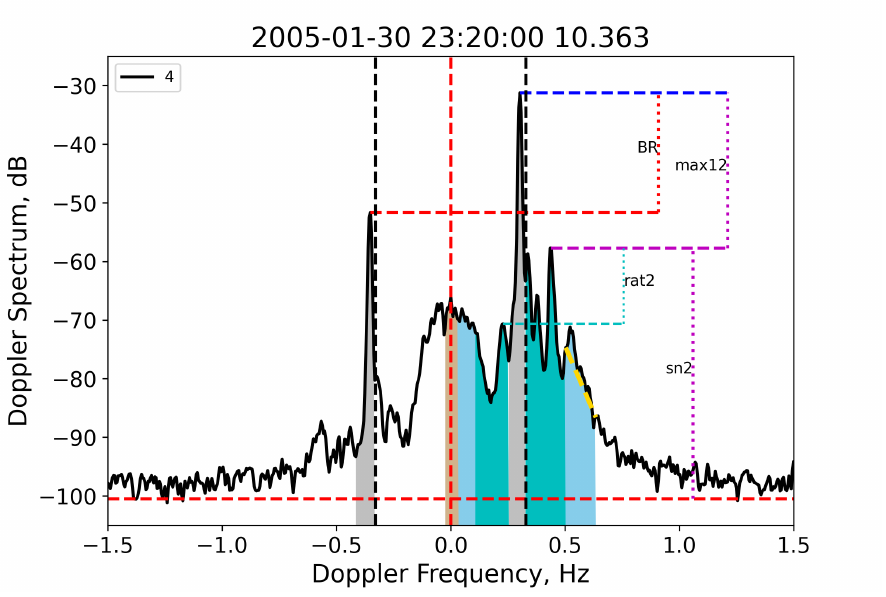
Figure 1. Sample Pisces Doppler spectrum (limited Doppler frequency range shown for clarity) showing features used. Lower red dashed line is the noise level. Vertical black dashed lines mark the position of the peaks with no current at this frequency. The two Bragg peaks are grey-shaded and marked with blue and red horizontal dashed lines and are displaced by a current component away from the radar; 2nd order peaks shown with magenta and cyan dashed lines; 2nd order region used for waveheight estimation in cyan, extension for period in light blue. The centre region is in brown. The yellow dashed line provides the slope parameter. Table 3. Doppler spectra features and metocean parameters used in the ML. RI is either R— feature could be related to wind speed or I—feature could impact on wind speed relationships of other